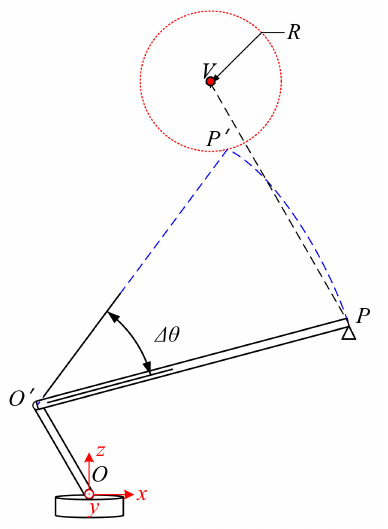
Figure 7. Collision urgency evaluation for pitching.